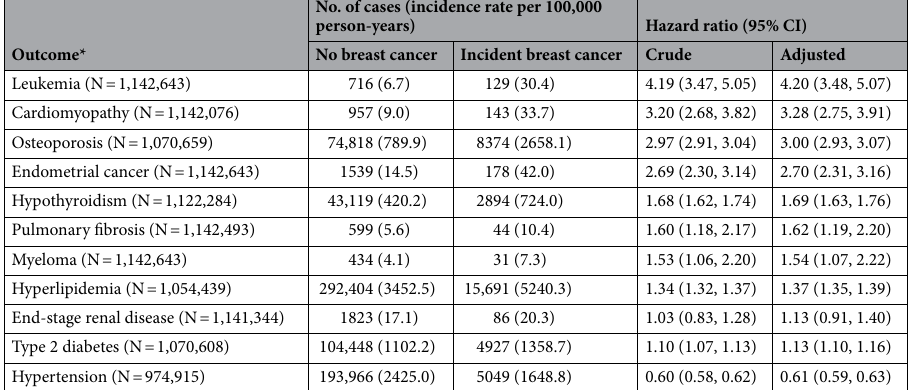
Table 2. Hazard ratios (95% confidence intervals) for incident outcomes after incident breast cancer. Each outcome was analyzed separately. Each analysis was performed among participants free of the outcome disease at baseline and adjusted for body mass index category (underweight, normal, overweight, obese, and unknown), alcohol intake (none, moderate, heavy, and unknown), physical activity (none, 1–2 times per week, ≥ 3 times per week, and unknown), smoking status (never smoker, ever smoker, and unknown), income percentile (Medical Aid, ≤ 30th, 31st–70th, > 70th percentile), as well as for the baseline presence of comorbid conditions other than the corresponding